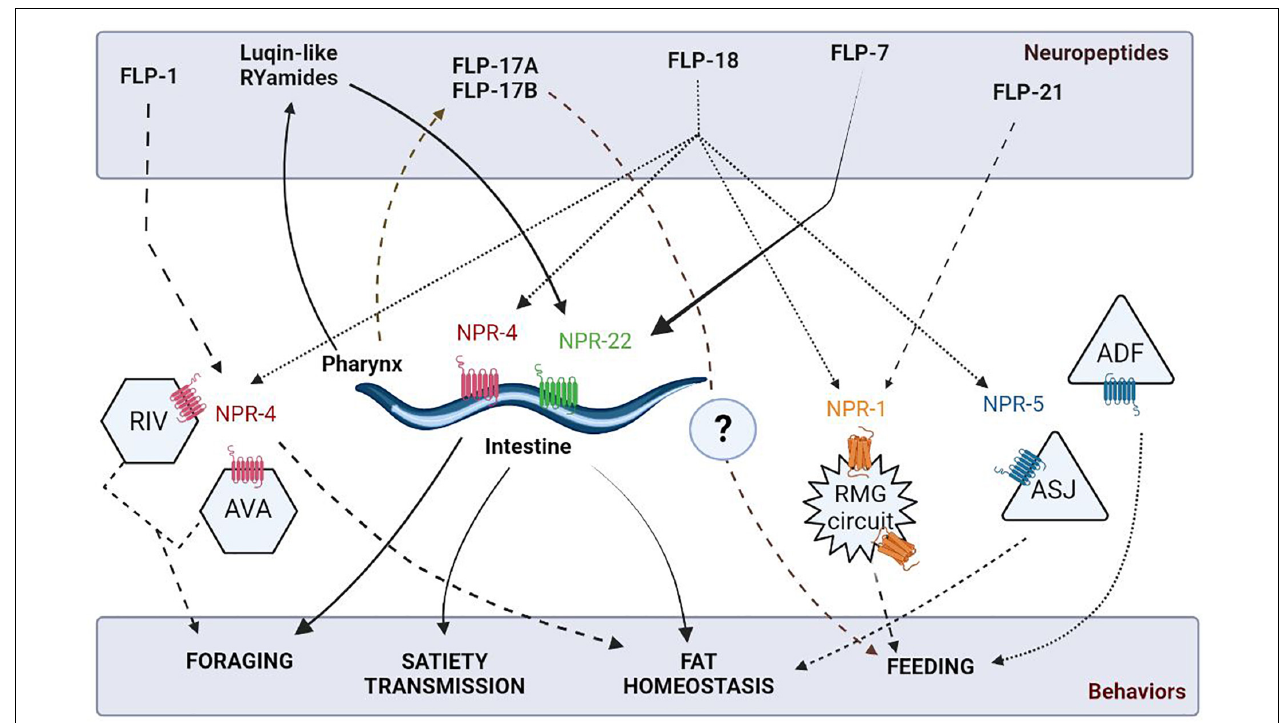
FIGURE 4 | Schematic of neuropeptidergic circuits underlying feeding related behaviors. The figure has been adapted from Cohen et al. (2009).